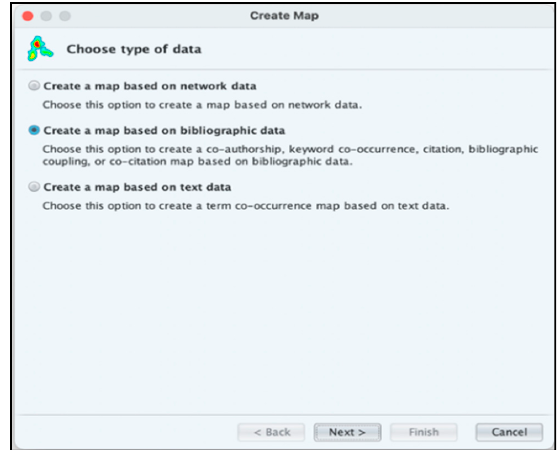
Figure A1. Selected “create a map based on bibliographic data.